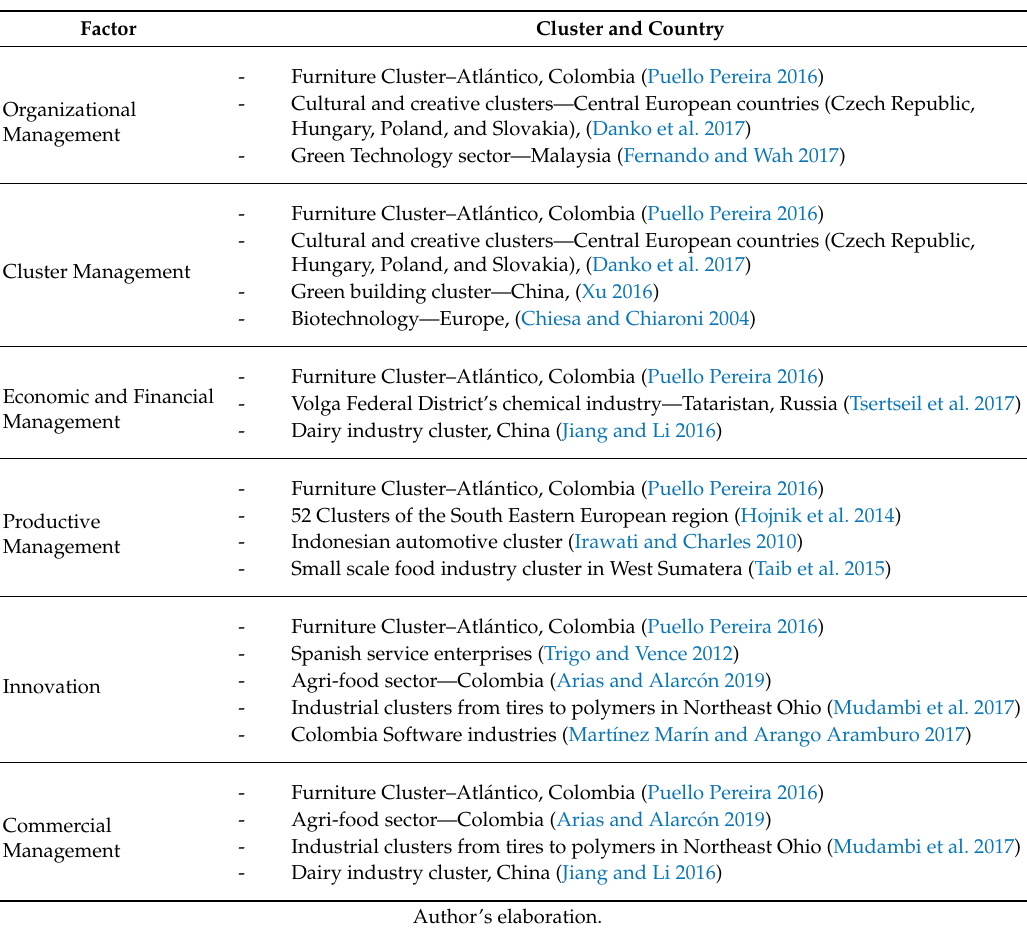
Table 3. Cluster Analysis